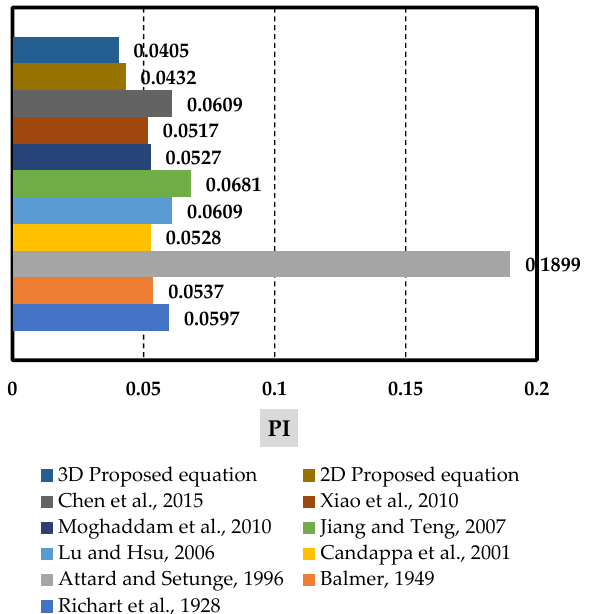
Figure 17. The diagrams of each indicator for the peak compressive strength models are presented by different researchers and the proposed models [25,26,68–74].